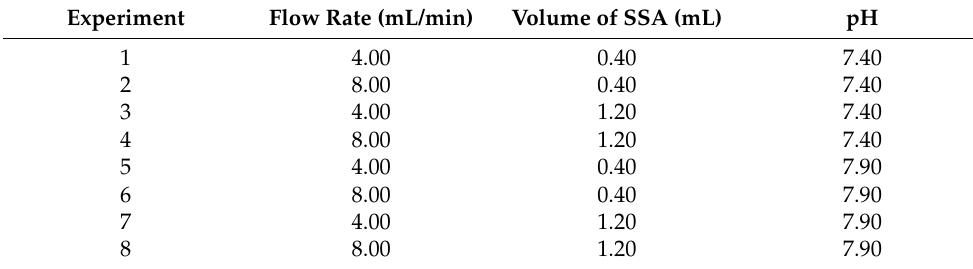
Table 6. Experimental design matrix according to a 2 3 full factorial